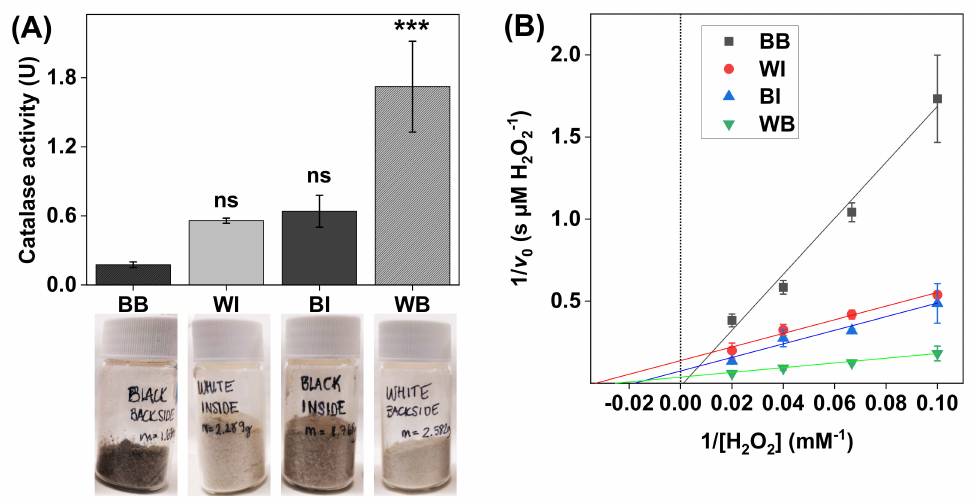
Figure 4. ( A ) Catalase activity in SC samples with noticeable differences in skin color (i.e., melanin content). All experiments were performed in triplicates ( n = 3, mean ± SD) with 10 mM H 2 O 2 at pH 7.5 and with the addition of 1.0 mg of SC sample in 5 mL of PBS. ( B ) Lineweaver–Burk plots obtained with 10, 15, 25, and 50 mM of H 2 O 2 , where linear extrapolations were used to determine the Michaelis constant K M and maximal reaction velocity v max according to Equation (6). The correlation coefficients were r 2 = 0.986 for black backside (BB), r 2 = 0.980 for white inside (WI), r 2 = 0.980 for black backside (BI), and r 2 = 0.999 for white backside (WB). *** p < 0.001 and ns = p >